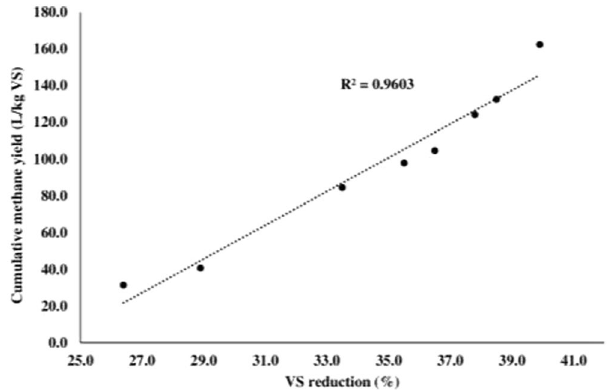
Figure 4. Correlation between cumulative methane yield and VS reduction.